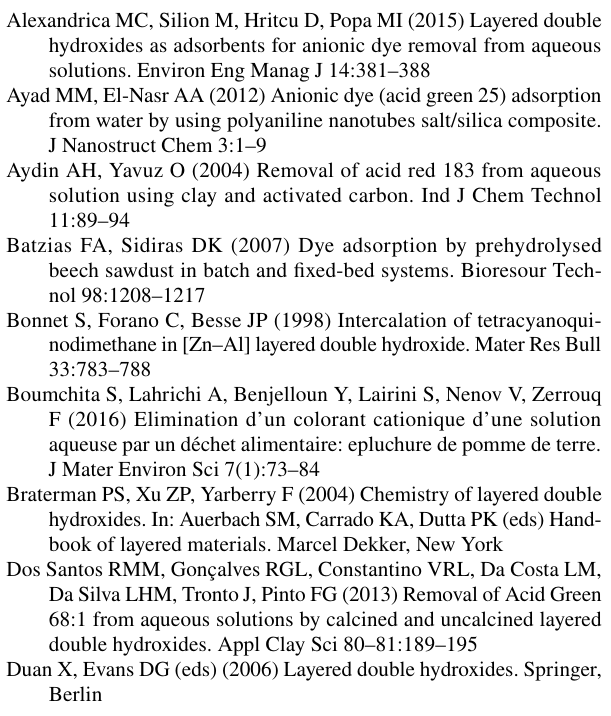
Fig. 13 The schematic illustration of AG1 intercalation between the LDH